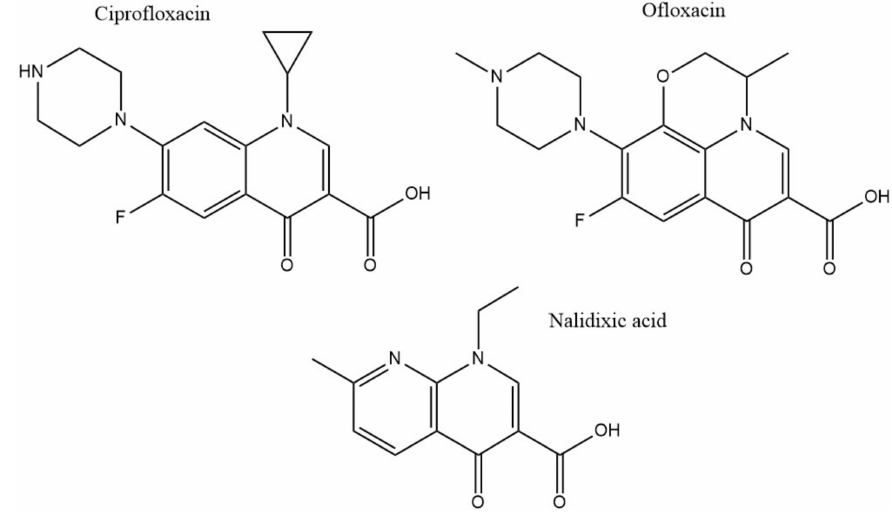
Figure 5. Chemical structures of three clinically used quinolone antibiotics is